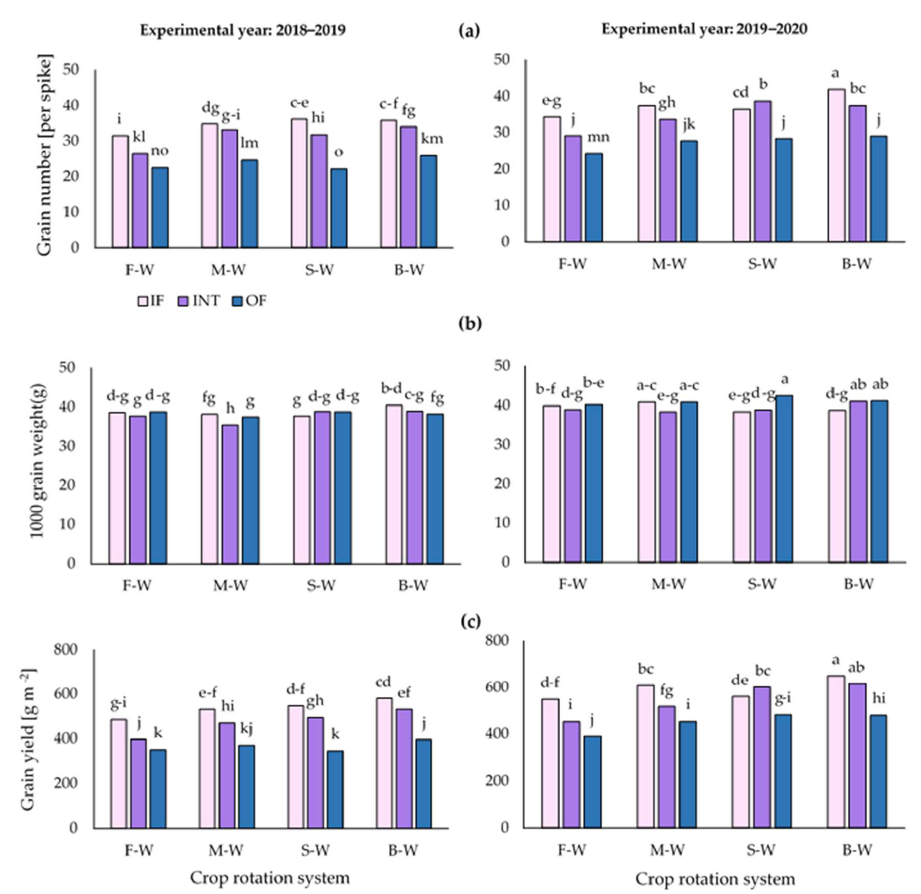
Figure 6. Effect of the interaction between three farm management practices (intensive, IF; organic, OF; and integrated, INT), and four crop rotation systems (fallow-wheat (F-W); maize-wheat (M-W); sesame-wheat (S-W) and mung bean-wheat (B-W) on ( a ) grain number per spike, ( b ) 1000-grain weight, and ( c ) grain yield during the two-year experiment. Different letters above each bar indicate a significant difference at p ≤ 0.05.